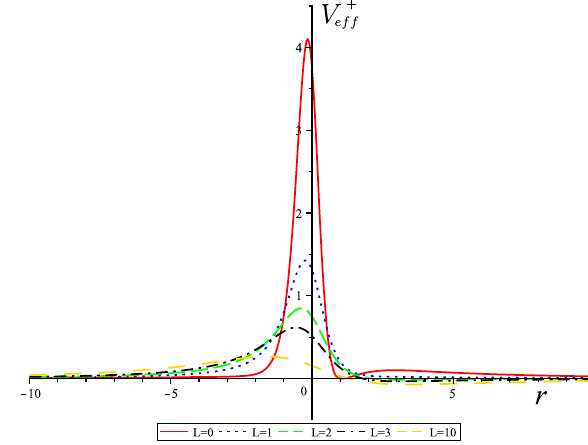
Fig. 2 Plots of V + versus r for the spin-( + 1 / 2 ) particles. The physical ef f parameters are chosen as; M = a = 1 , and λ = − 1 . 5